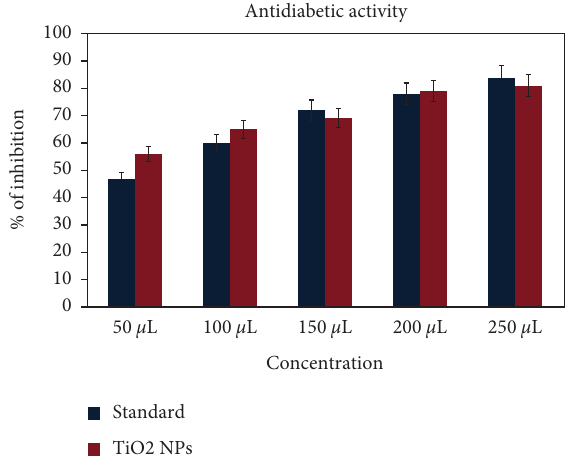
Figure 10: Antidiabetic activity of TiO